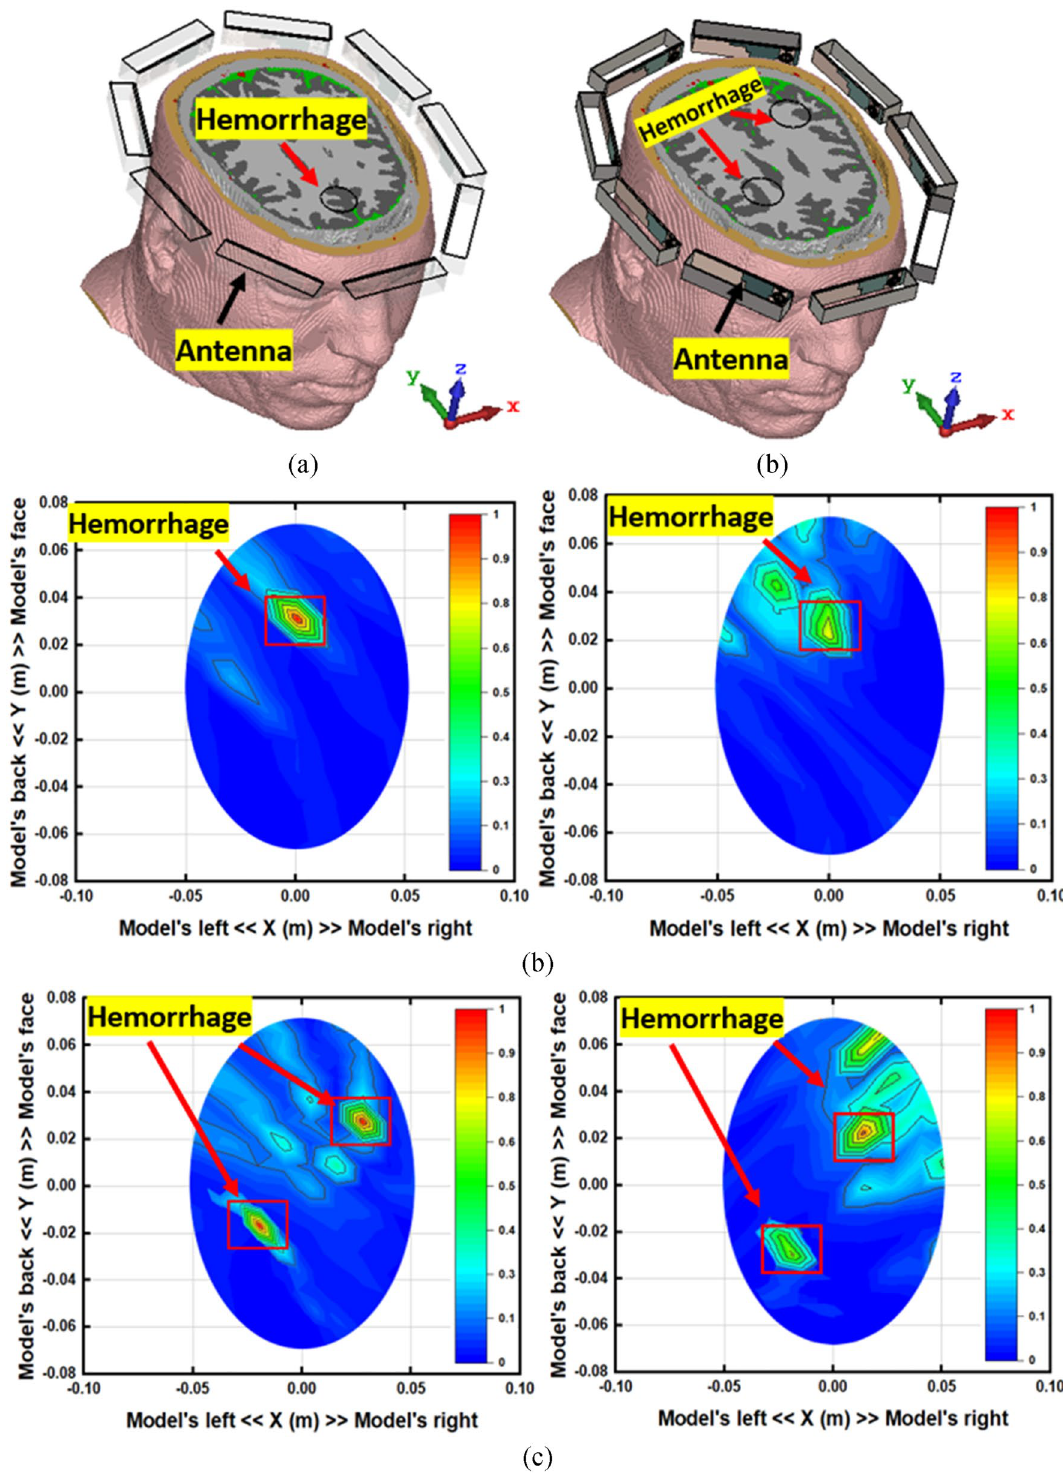
Figure 22. Simulated near-field image reconstruction ( a ) Perspective head model with single and double hemorrhage ( b ) single hemorrhage detection with and without MTM loaded antenna ( c ) double hemorrhage detection with and without MTM loaded